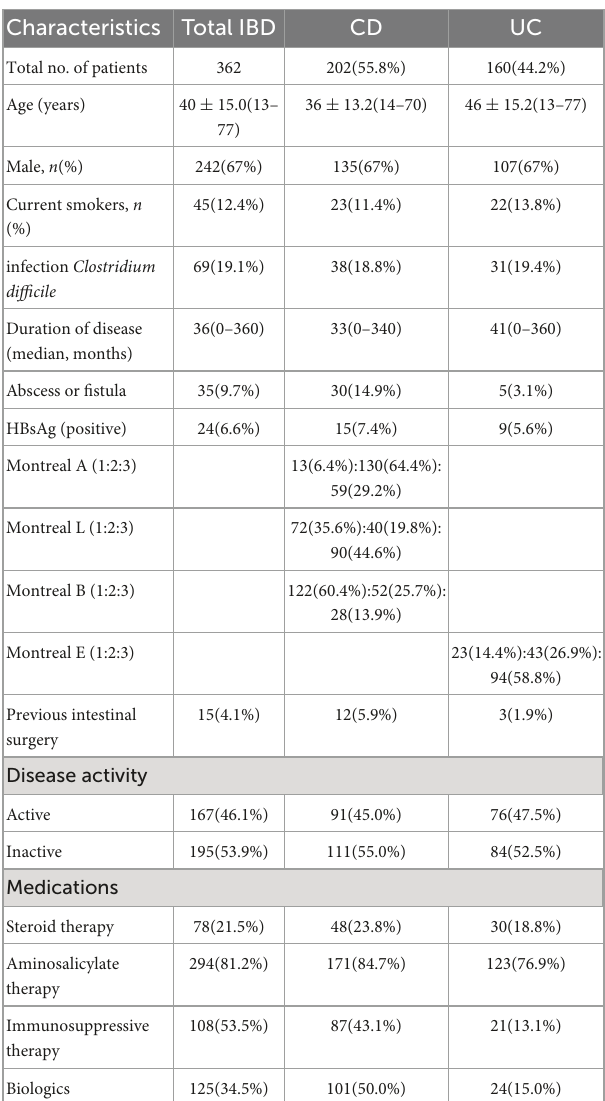
TABLE 1 Study demographics, Montreal classification, and disease behavior for inflammatory bowel diseases (IBD) patient samples in this